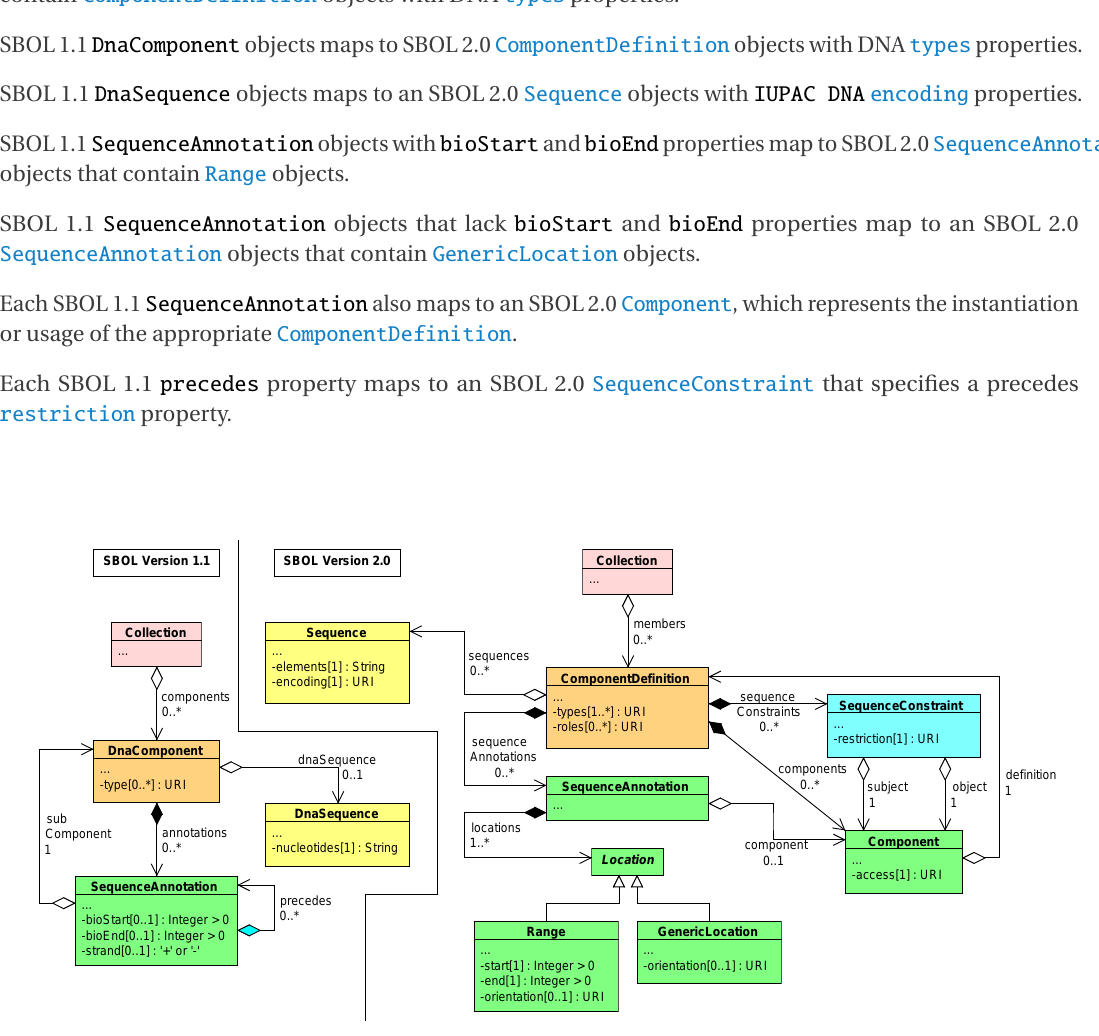
Section 8 Mapping Between SBOL 1.1 and SBOL